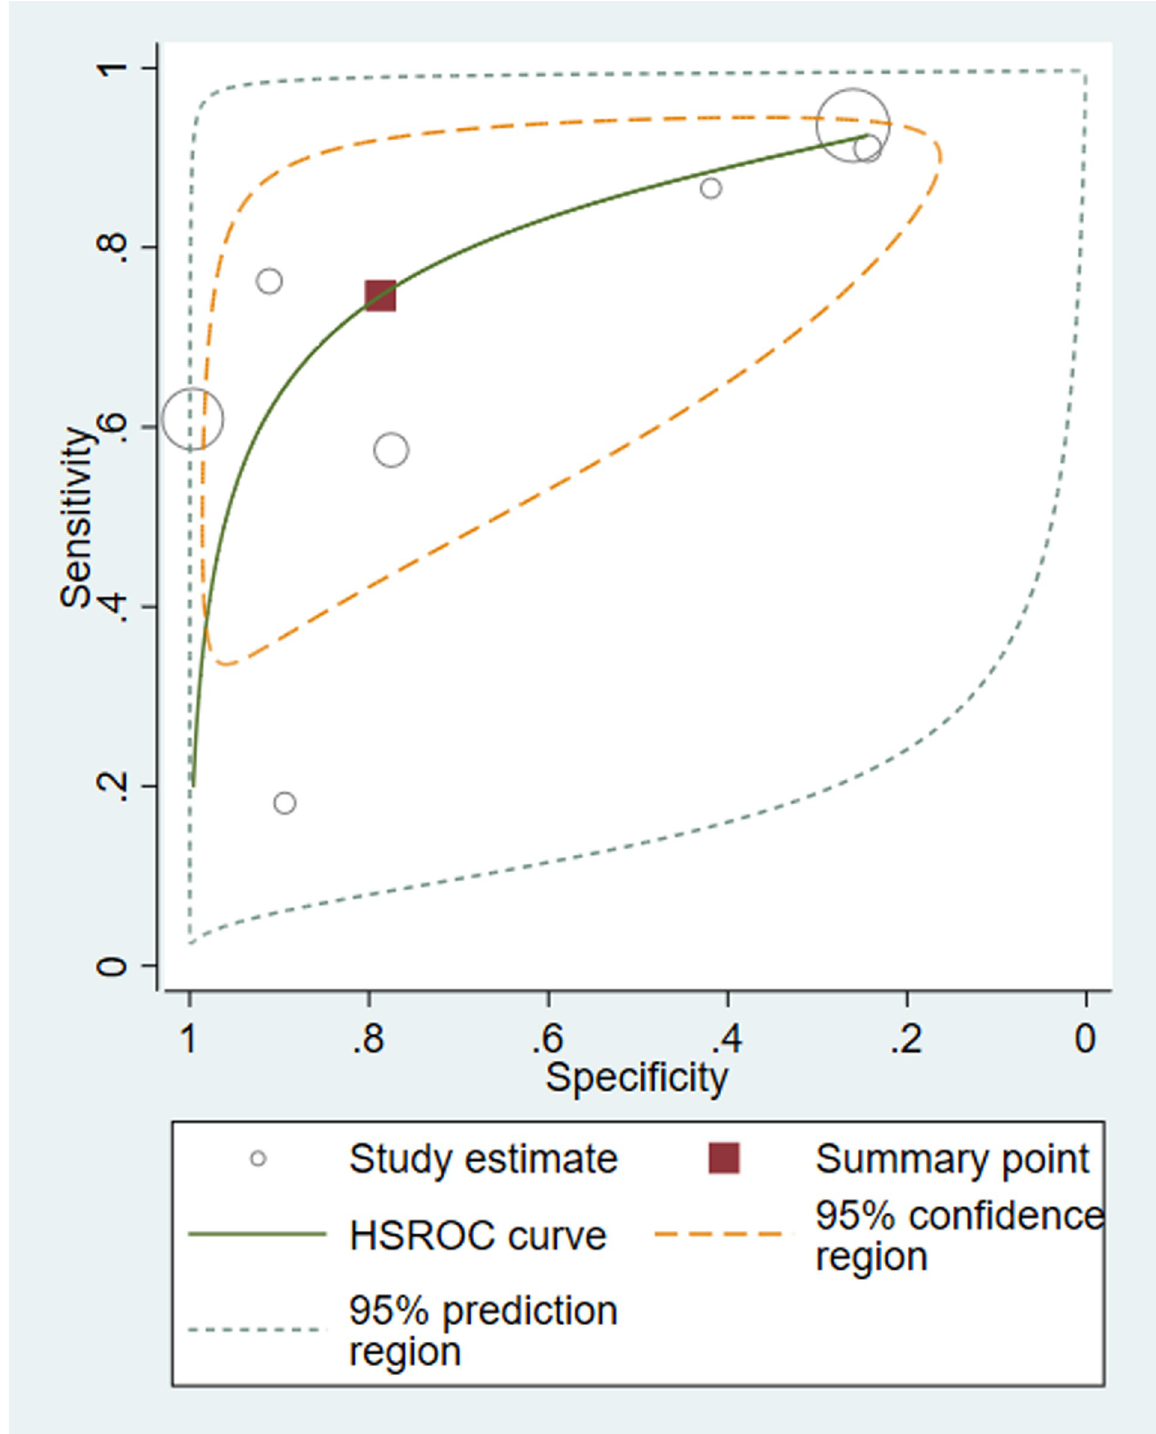
Fig 5. HSROC for d-dimer levels and occurrence of pulmonary embolism in patients with CAP. HSROC, hierarchical summary receiver operating characteristic curve.